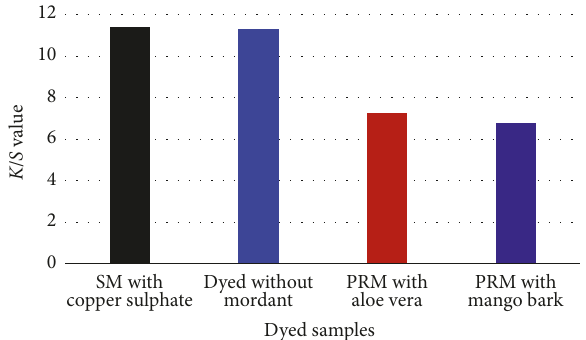
Figure 3: Maximum (𝐾/𝑆) value of selected dyed leather samples at wavelength of 400nm.